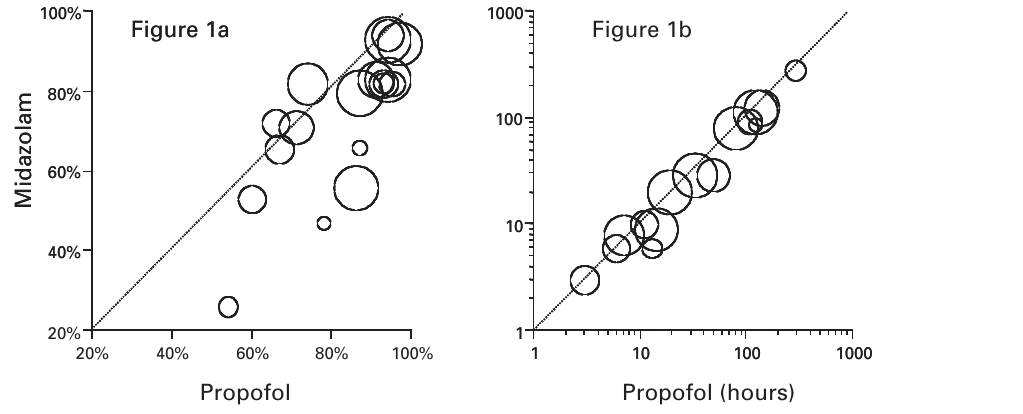
Figure 1 a Efficacy of sedation